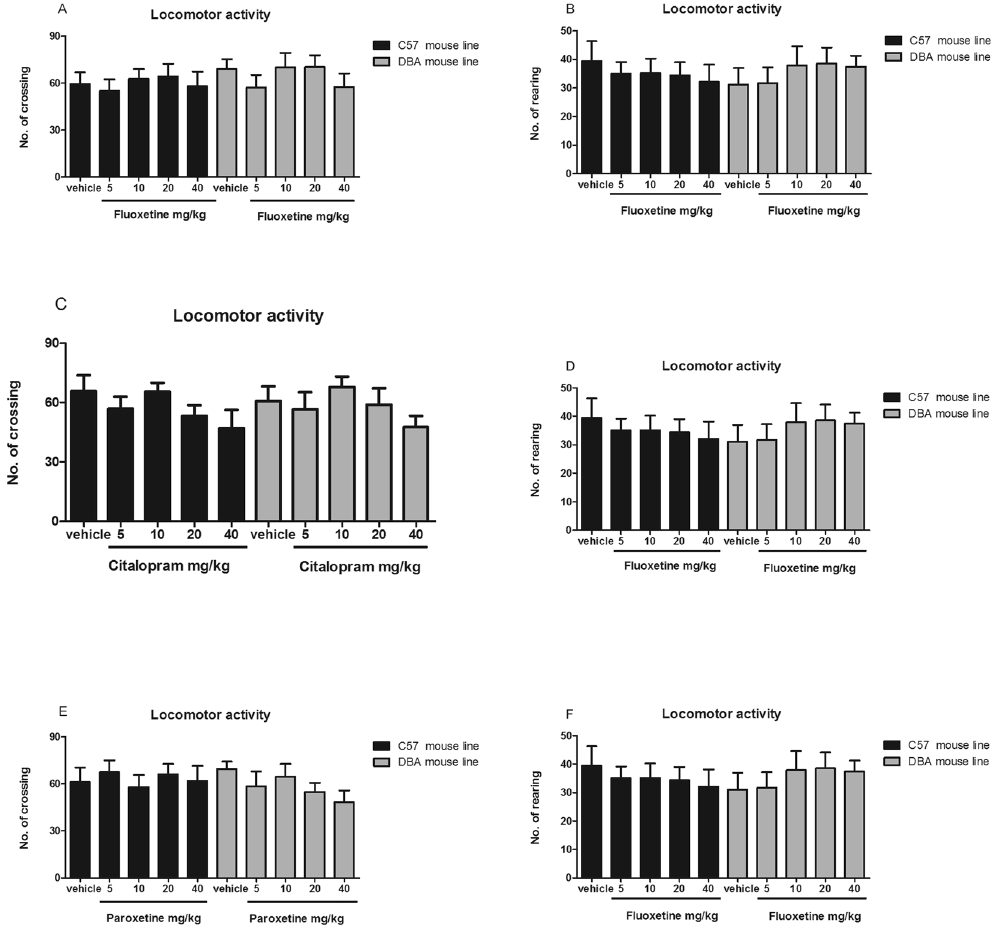
Figure 3. Effects of fluoxetine ( A , B ), citalopram ( C , D ) and paroxetine ( E , F ) on immobility time in the forced swimming test in DBA/2J and C57BL/6J mice. All tests were performed 30 min after i.p. injection of 5, 10, 20, or 40 mg/kg drug. Data are presented as the mean ± S.E.M. (n = 8–10/group). * p < 0.05, ** p < 0.01, *** p < 0.001 versus